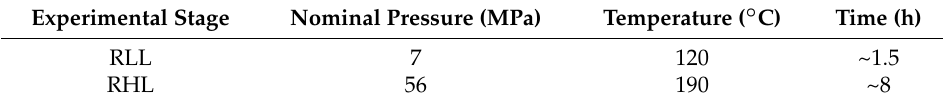
Table 1. Experimental conditions.